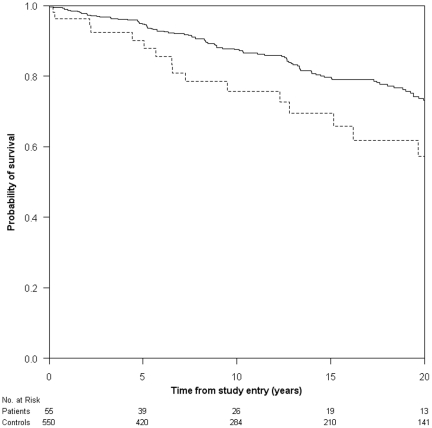
Kaplan-Meier survival curve of patients with tuberculous meningitis (dashed line) and population controls (solid line), Denmark, 1972–2008.